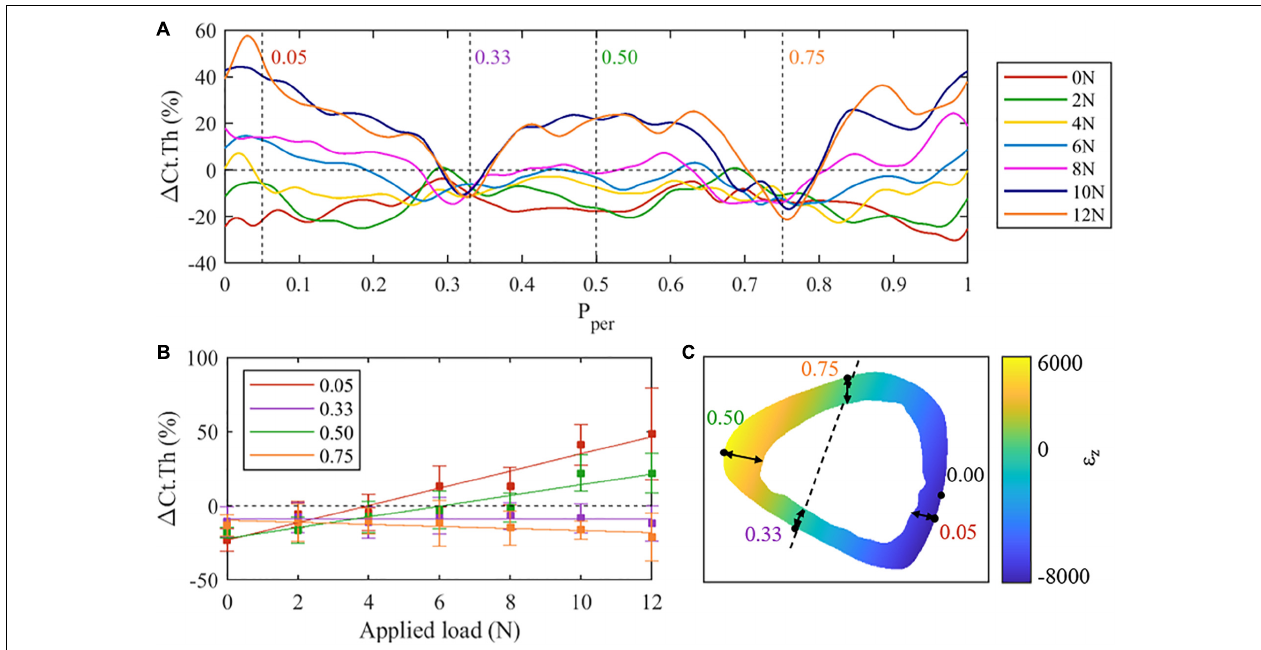
FIGURE 3 | (A) Mean cortical thickness changes ( (cid:49) Ct.Th) along the normalised periosteal position at the middle tibial cross-section (z = 50%) for all loading cases. Regions of interest have been identified at P per = 0.05 (posterior surface), 0.33 (lateral), 0.50 (anterior), and 0.75 (medial). (B) Mean cortical thickness changes at selected regions of interest across all loading conditions. (C) Finite element results (F = 10 N) within the 50% cross-section.